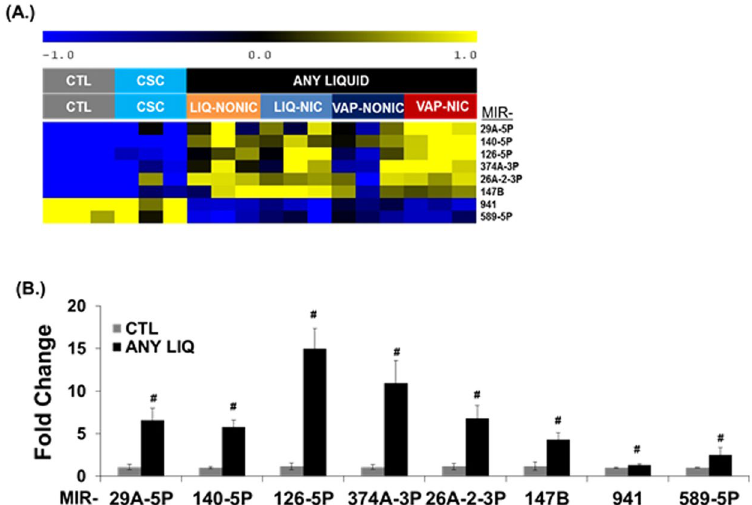
Figure 4. qPCR validation of miRNA expression in eCig exposed human lung epithelial cells ( A ). Differential expression of selected miRNAs. Validation was attempted on eight miRNAs chosen based on their magnitude of change and biological interest. Shown are normalized expression levels for these 8 selected miRNA. Rows represent miRNA and columns represent samples. Blue indicates low expression, while yellow indicates high expression. Individual treatment groups were untreated control (CTL), cigarette smoke condensate (CSC), non- vaporized liquid without (LIQ-NONIC) or with (LIQ-NIC) nicotine, and vaporized/condensed liquid without (VAP-NONIC) or with (VAP-NIC) nicotine. ( B ) Validation of microRNA expression by qPCR. We used qPCR to confirm expression patterns predicted by RNA-Seq analysis for 8 miRNA (MIR29A-5P, MIR140-5P, MIR126P, MIR374A-3P, MIR26A-2-3P and MIR147B, MIR941 and MIR589-5P) that were induced following treatment of any eCig liquid (ANY LIQUID). We successfully validated differences in expression for 6 of these 8 miRNA. # p < 0.05; #! p < 0.056 (MWU) (CTL vs any ANY LIQ).